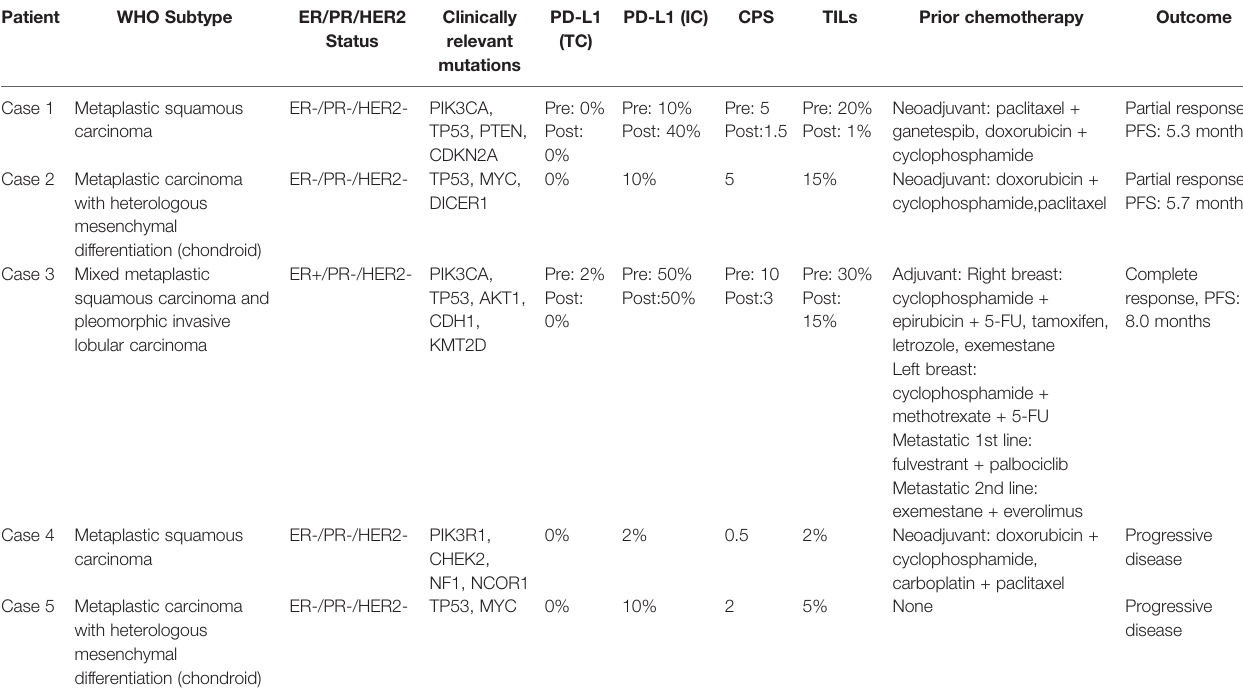
TABLE 6 | Patient Characteristics. Patient WHO